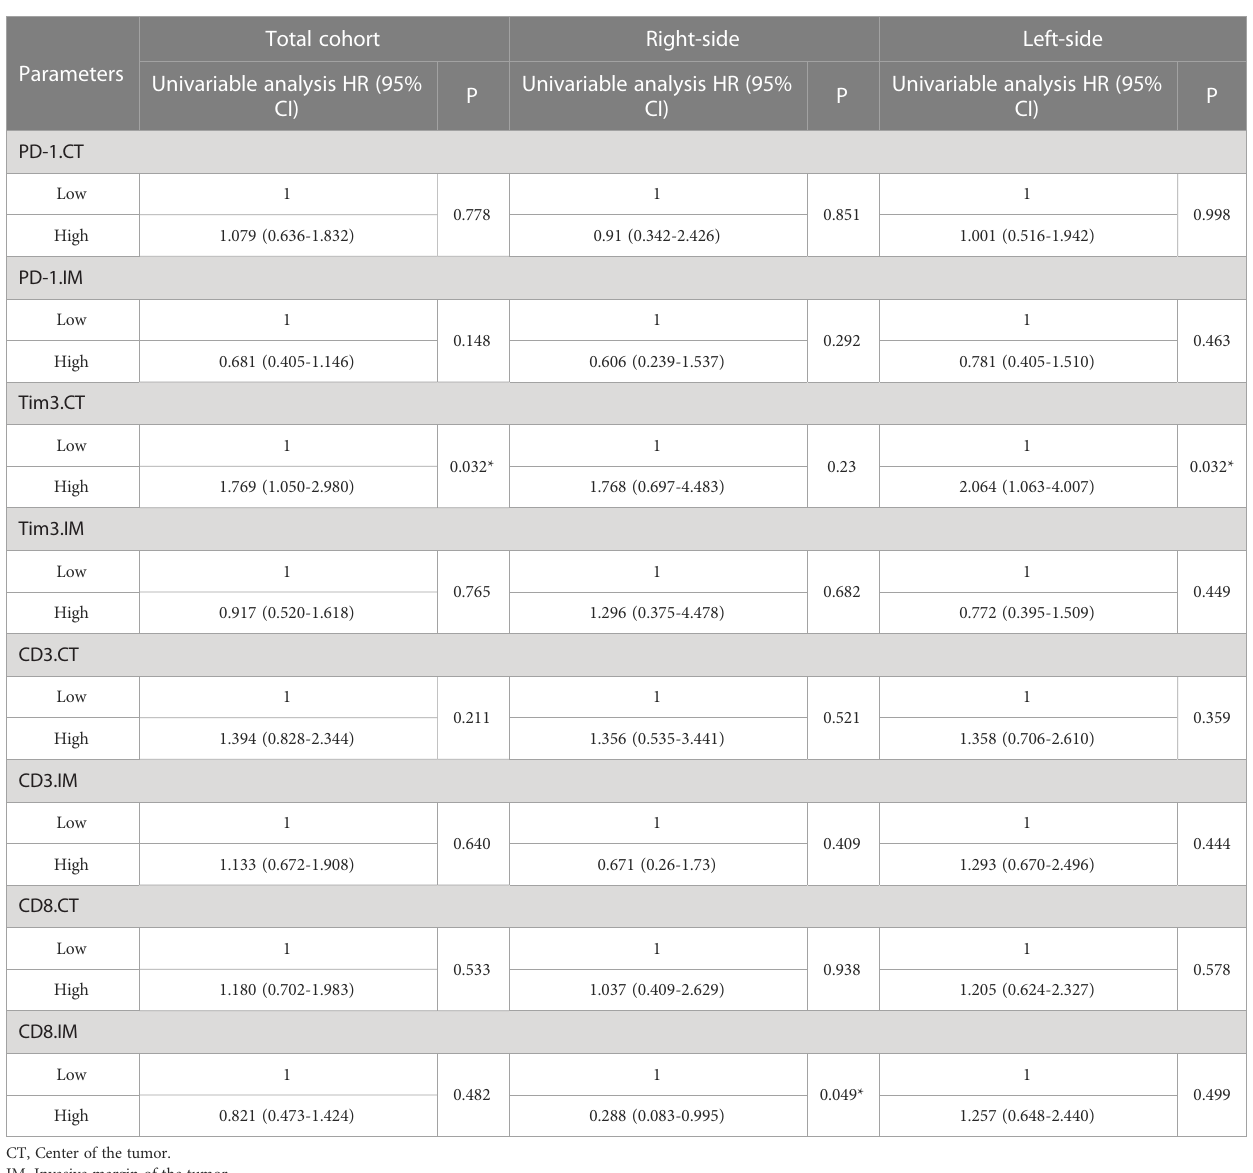
TABLE 7 Cox regression survival analysis according to right and left-sided subgroups.